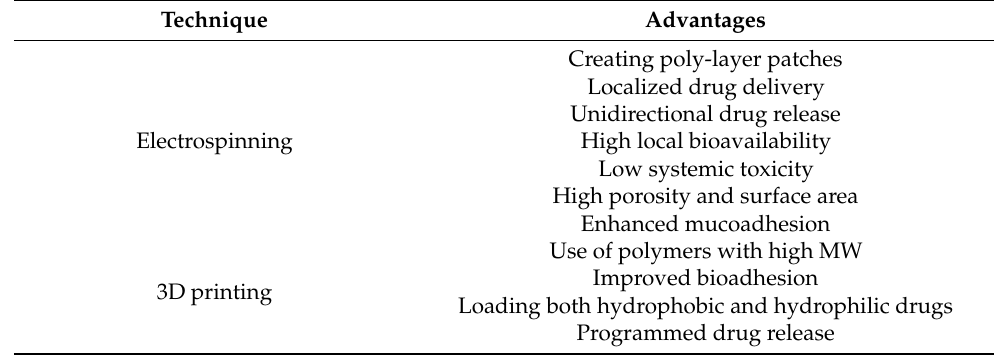
Table 5. The main advantages of patches obtained by various innovative